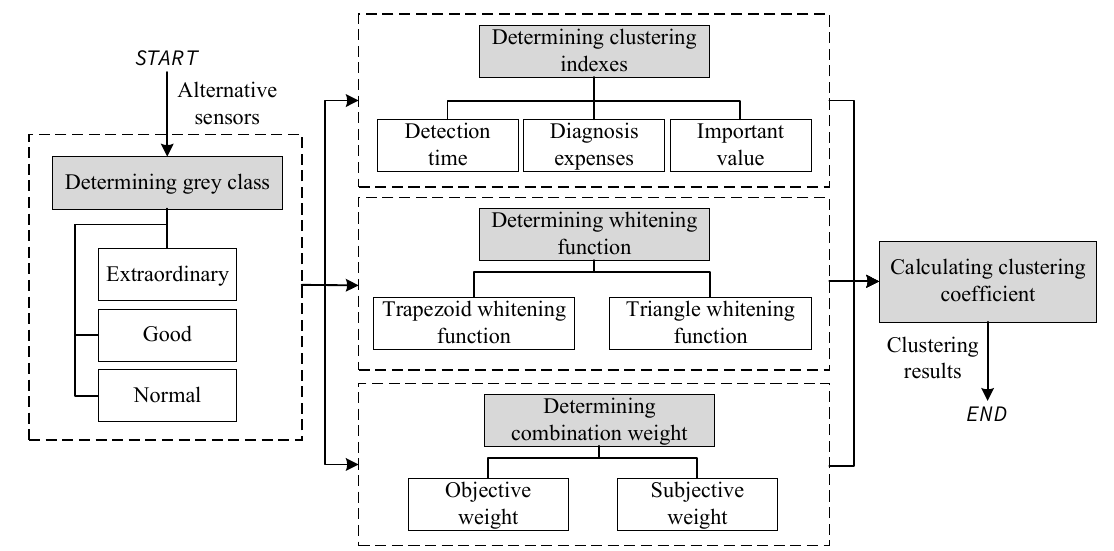
Figure 1. The workflow of the proposed method.